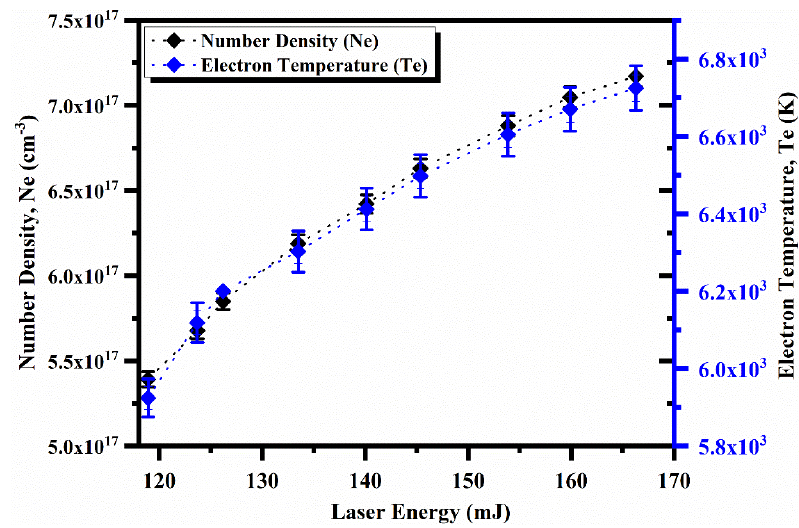
Figure 5. Variation in the electron temperature and the electron number density for Ga as a function of laser irradiance.